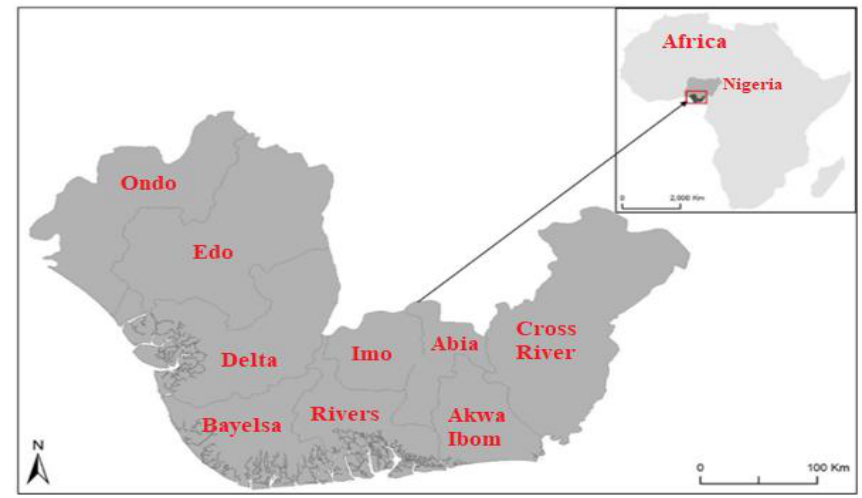
Figure 1. Map of Nigeria showing the nine states of the Niger Delta.